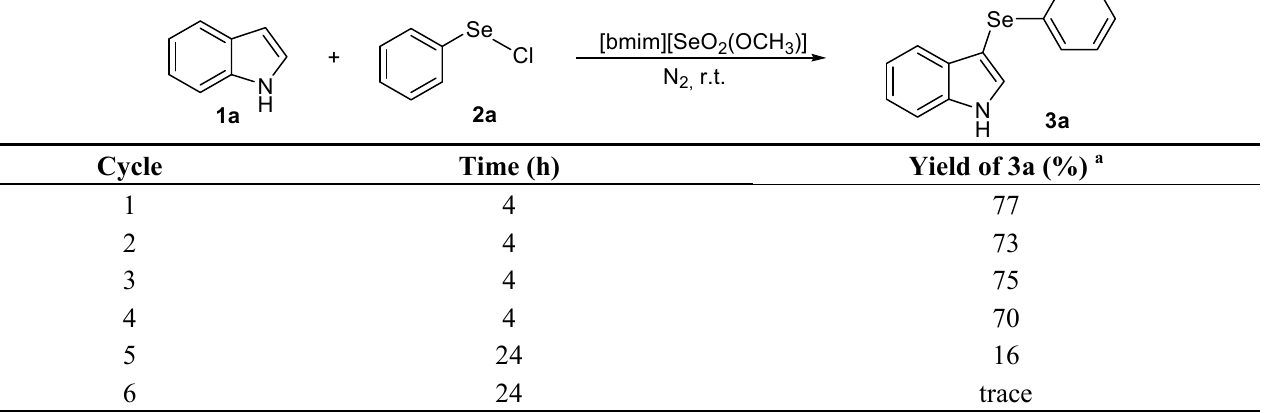
Table 3. Reuse of [bmim][SeO